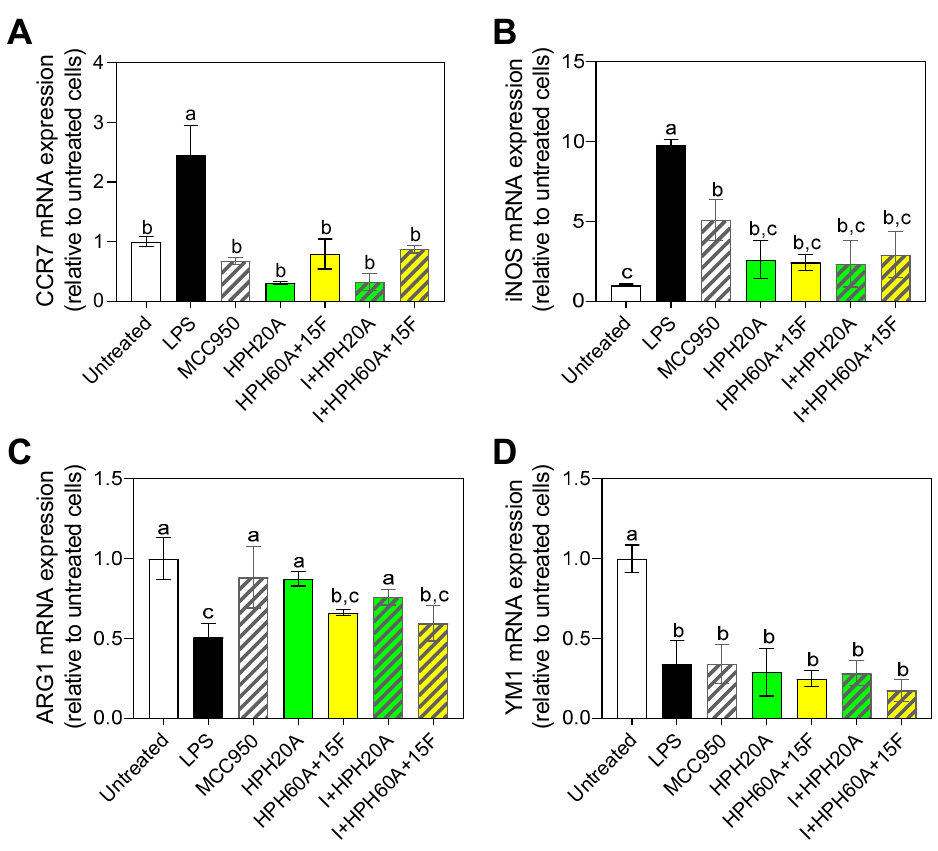
Figure 5. Gene expression of markers of polarization toward phenotypes M1, Ccr7 ( A ) and iNos ( B ), and M2, Arg1 ( C ) and Ym1 ( D ) in BV-2 cells after 24 h incubation with or without stimulation with LPS (1 µ g/mL), as well as following treatment with MCC950 (I) and/or HPHs (100 µ g/mL). Values are presented as the means ± SDs ( n = 3); Different letters denote significant differences among the samples. ( p < 0.05).